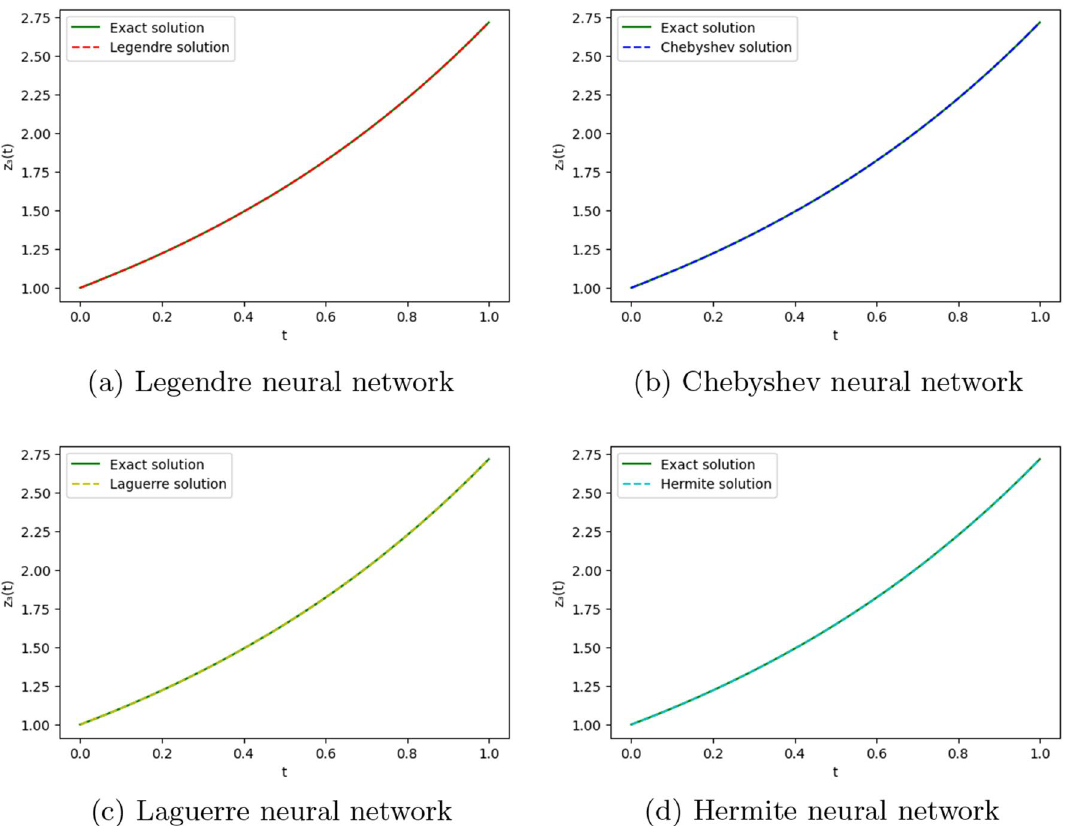
Figure 19. Comparison of the exact solution z 3 ( t ) with the obtained approximate solutions of Example 7.3.